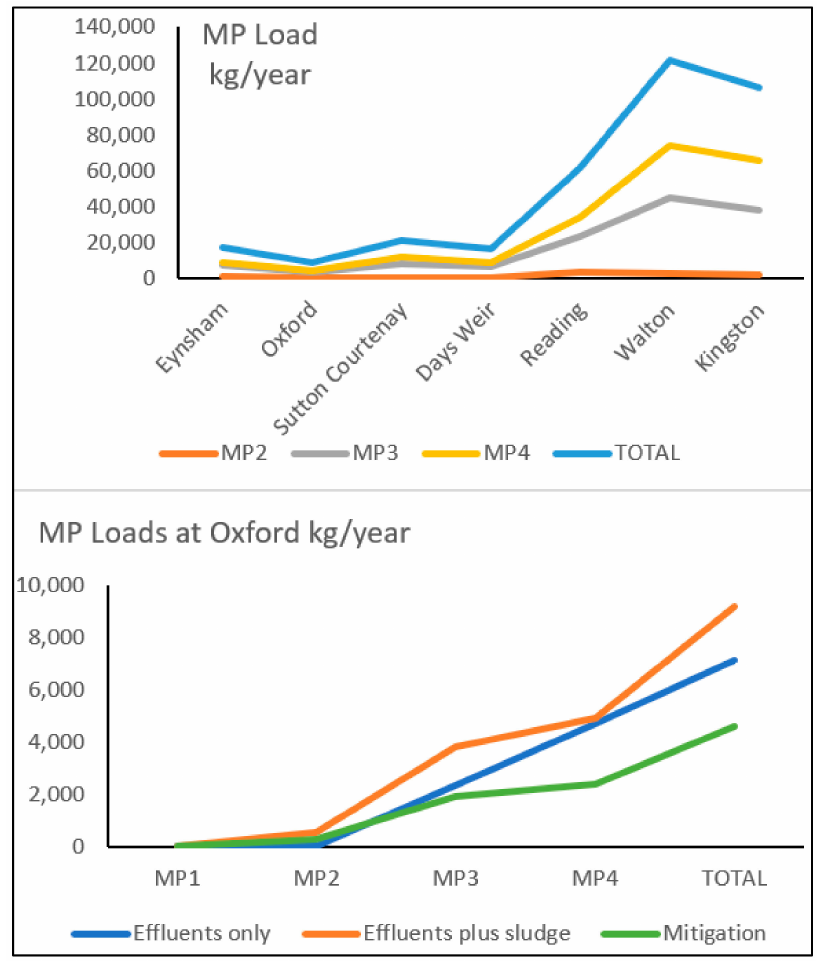
Figure 4. Model results showing microplastic loads (kg/year) at reach locations down the River Thames ( top ) and loads at Oxford for the different microplastics classes and for the three scenar- ios ( bottom ). Table 3. Average annual suspended microplastics mass load (kg/year) by microplastic particle size and by river reach (scenario